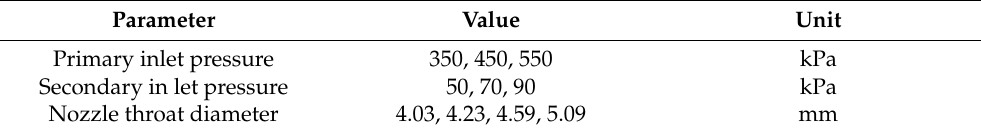
Table 16. The experimental conditions in